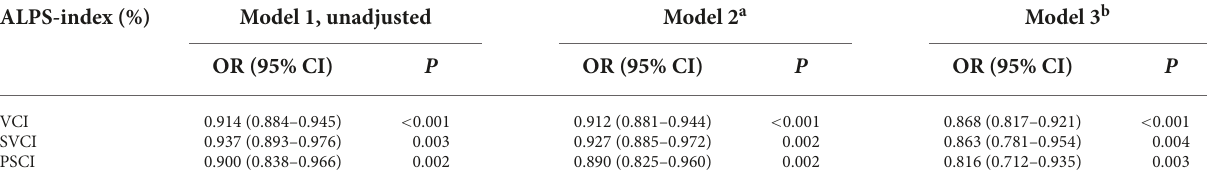
TABLE 2 Univariate and multivariate logistic analyses of the association between ALPS-index and VCI, SVCI, and PSCI. ALPS-index (%)